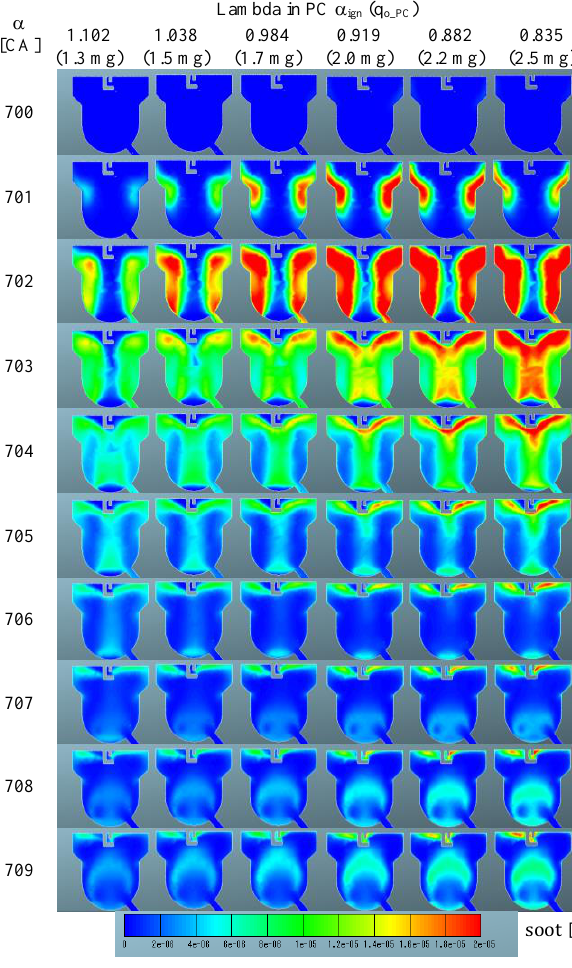
Fig. 18. Influence of the fuel dose fed to the prechamber on the resulting soot mass